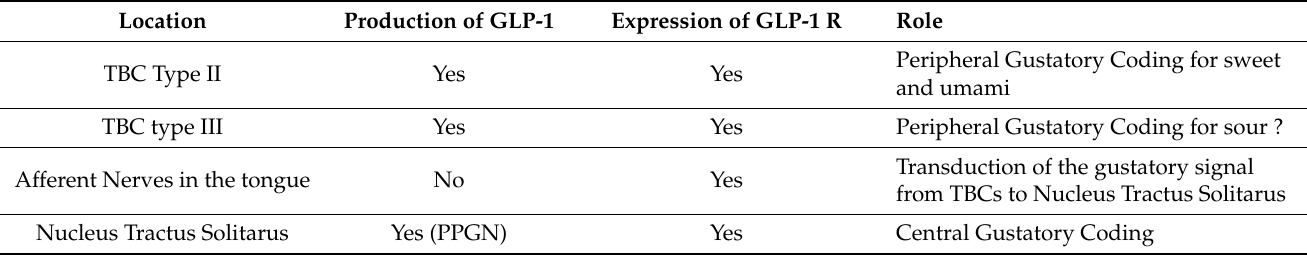
Table 1. Summary of the GLP-1/GLP-1 R effects in the gustatory